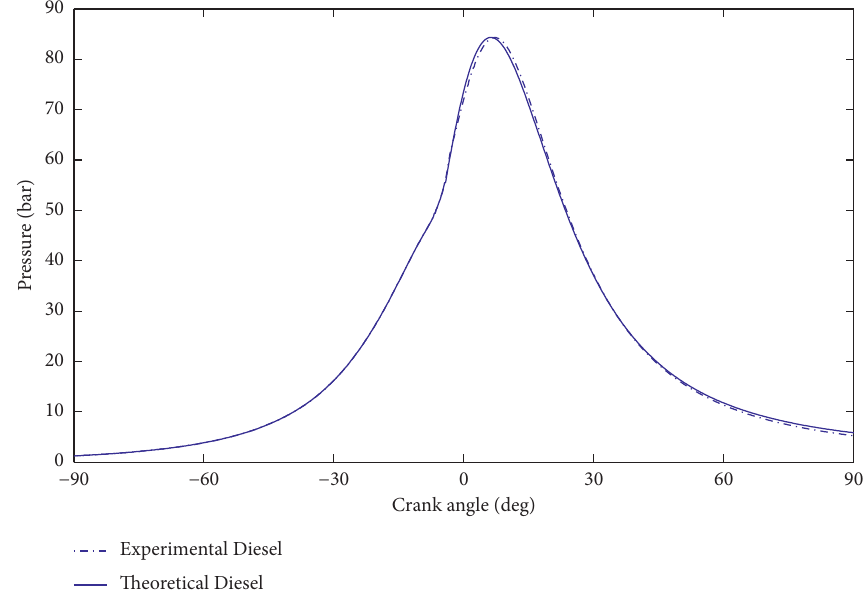
Figure 3: Comparison of experimental and theoretical pressures for diesel fuel.